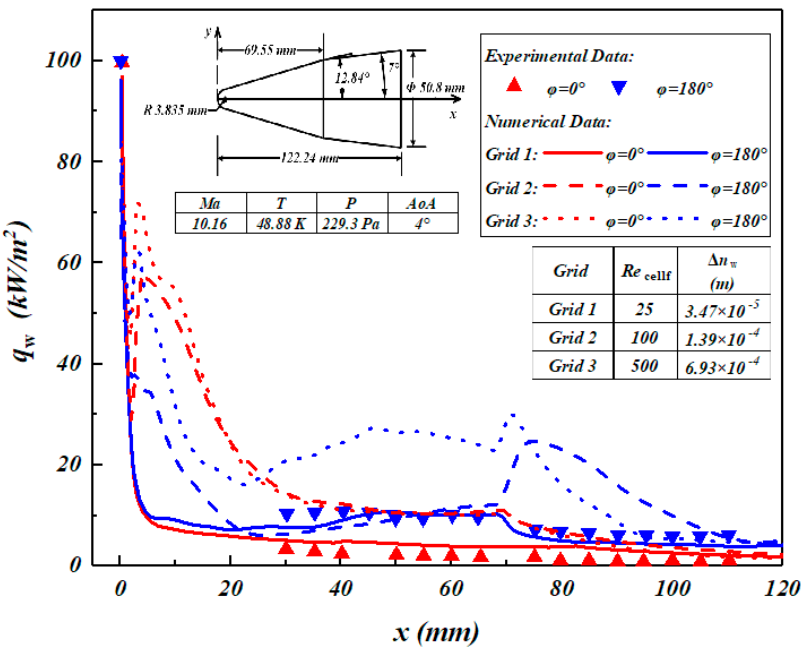
Figure 2. The comparison of the aerodynamic heat flux ( q w ) between numerical data and experimen- tal data in [26].